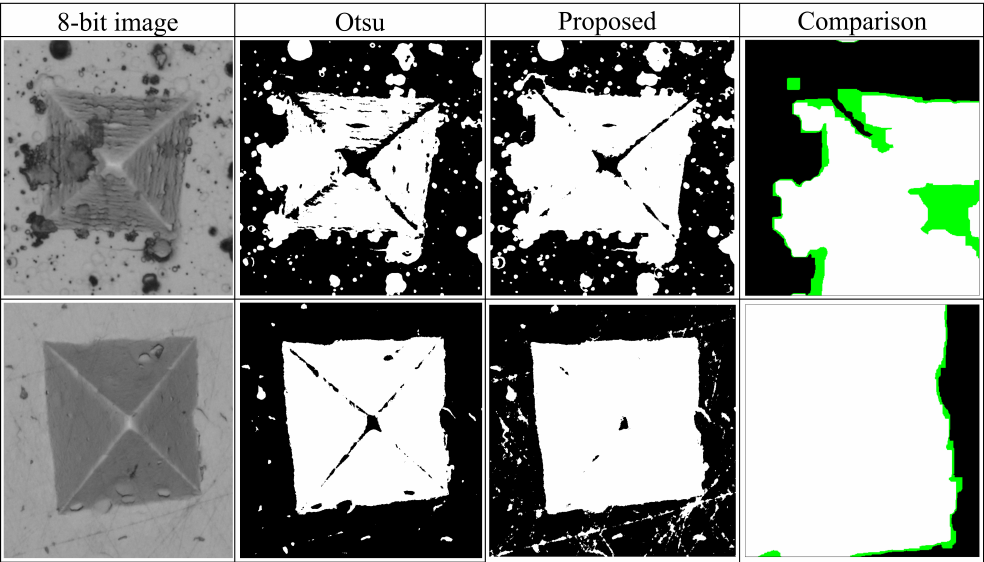
Figure 6. Threshold techniques evaluation. The comparison section shows Otsu (in white) and the proposed method (in green) after the filter by area